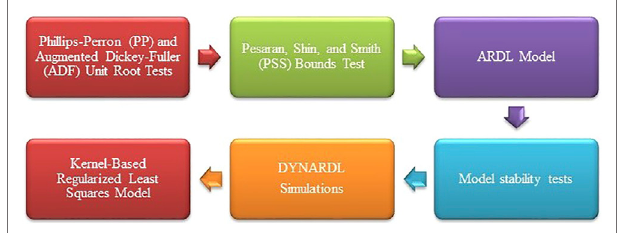
FIGURE 1 | The Proposed Methodology.